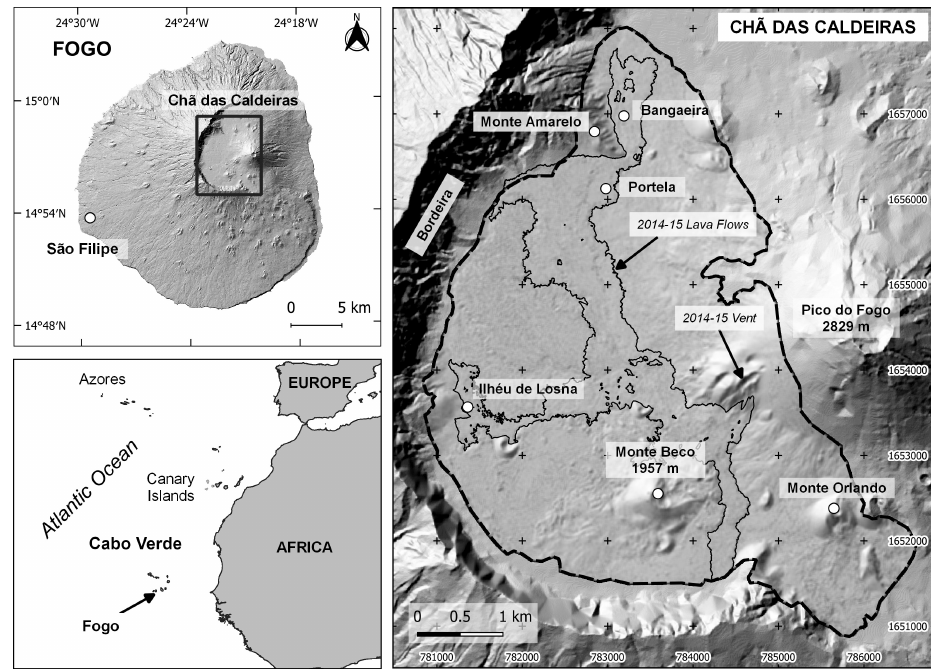
Figure 1. Location of the Chã das Caldeiras and of the surveyed area (dashed line) on Fogo (Cabo Verde). The 2014/15 lava flows are limited by a thin black line. Shaded relief derived from the DEMFI (2010) 5m DEM.